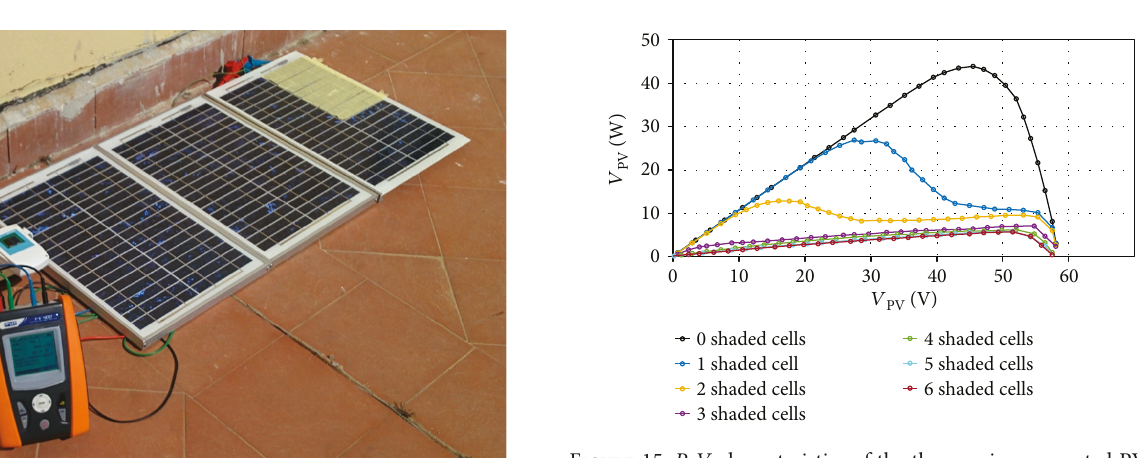
Figure 13: Three series-connected PVUs equipped with the IV Tracker. 27 September 2017, Aversa (CE), Italy. S 1 = 775W/m 2 characterizes the unshaded cells, and S 2 = 180W/m 2 characterizes the shaded cells; T amb = 26 ° C .